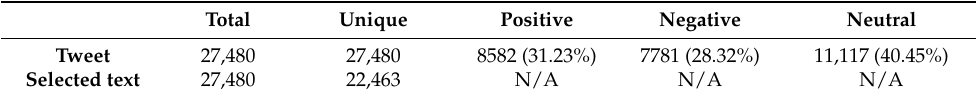
Table 3. Tweet sentiment dataset.